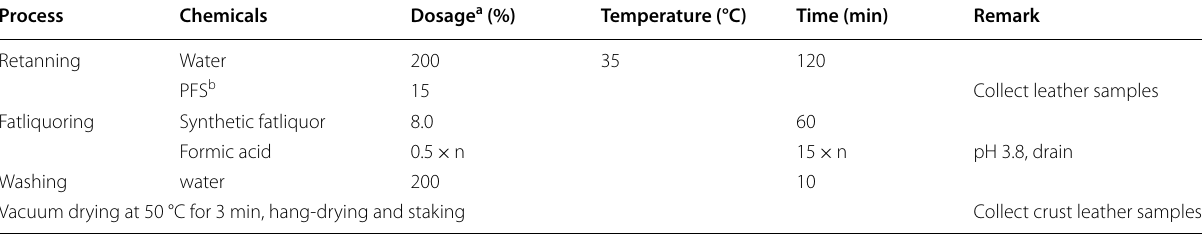
Table 1 Retanning and fatliquoring processes Process